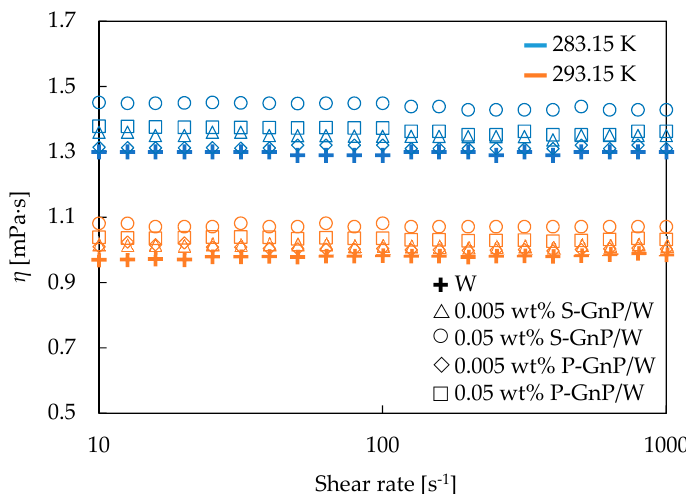
Figure 2. Flow curves for the different loaded S-GnP and P-GnP nanofluids in the 10 to 1000 s − 1 shear rate range at 283.15 K (blue) and 293.15 K (orange).